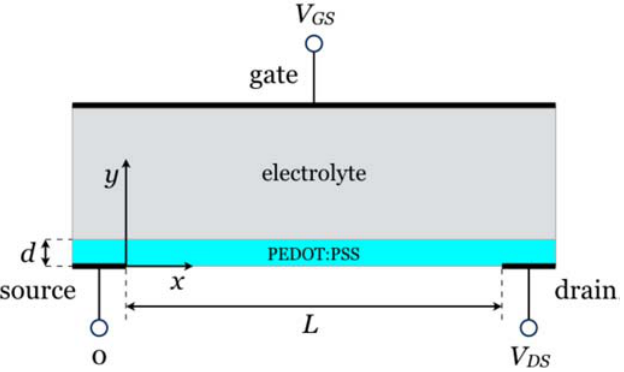
Figure 5. General view of an OECT. x and y axes correspond to the directions along and across the polymer film, respectively.